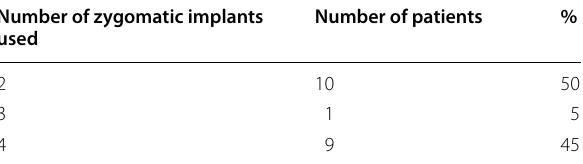
Table 5 Implant design used as a function of ZAGA classification Number of patients